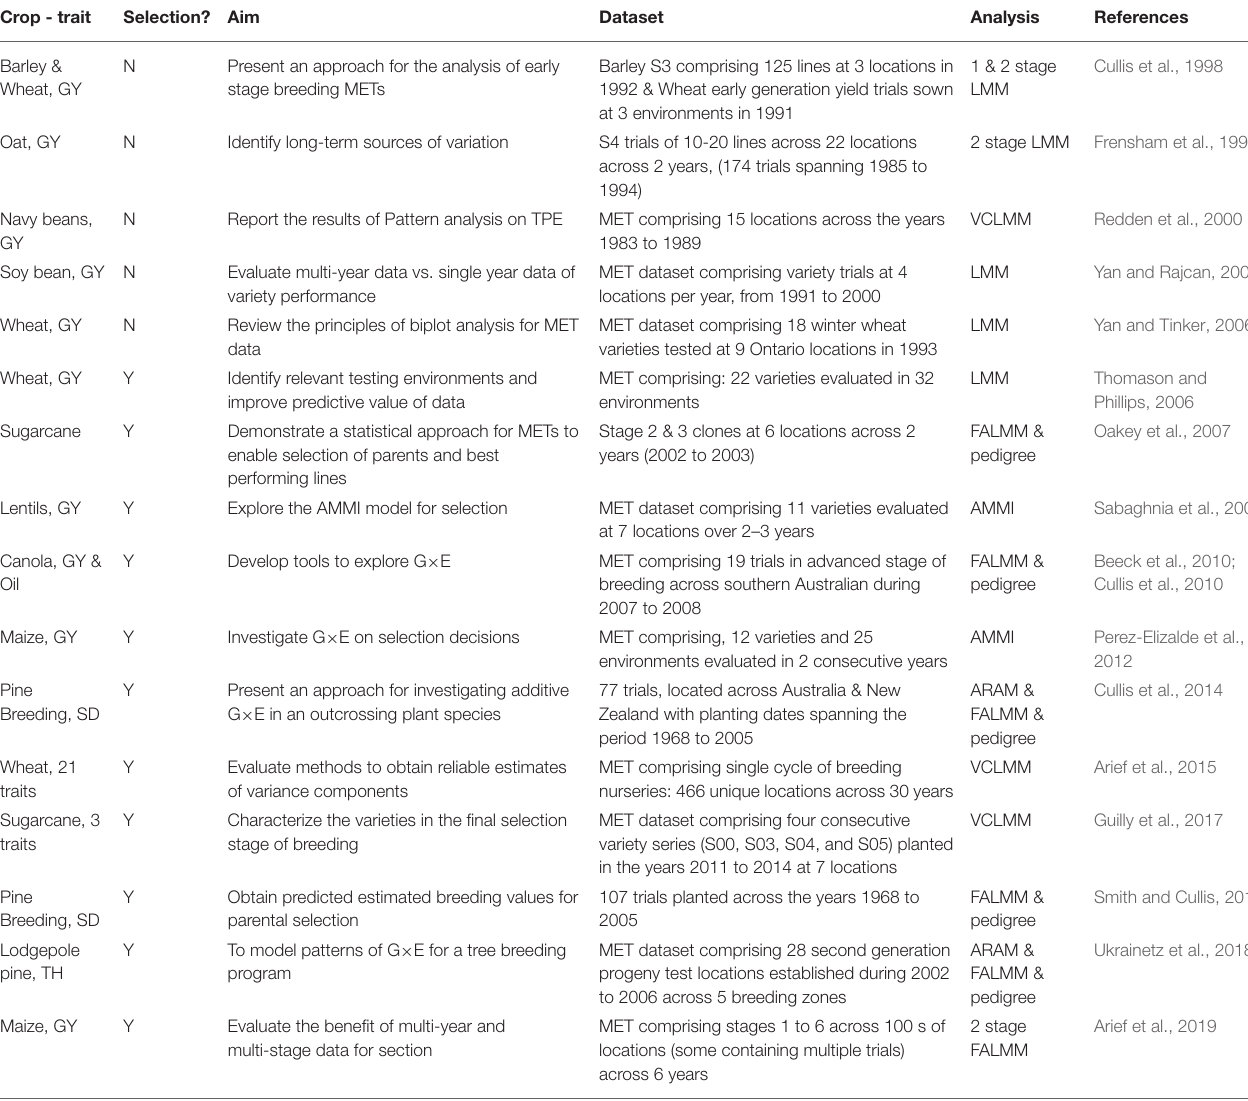
TABLE 1 | Summary of studies based on plant breeding METs, their dataset composition, and methods of analysis. Crop -